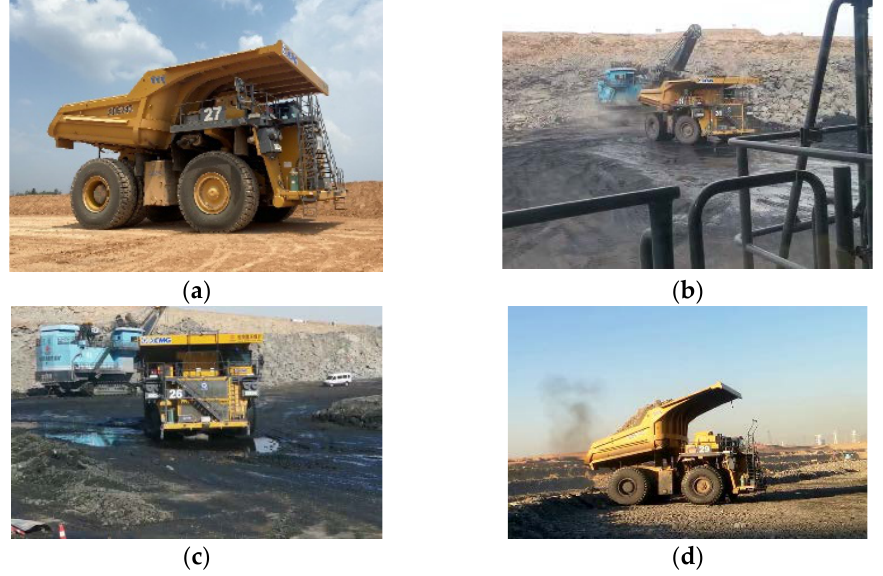
Figure 10. Field test scenario: ( a ) mining truck, ( b ) loading job scenarios, ( c ) autonomous driving operation scenario, and ( d ) unloading job scenario.